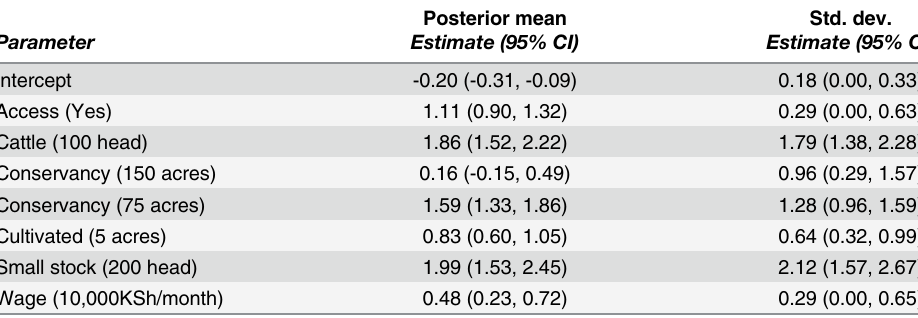
Parameter estimates from Model 1, a mixed logit model with only choice attributes (i.e. the experimentally manipulated characteristics which de fi ned each choice situation, e.g. number of cattle; Table 2) included as predictor